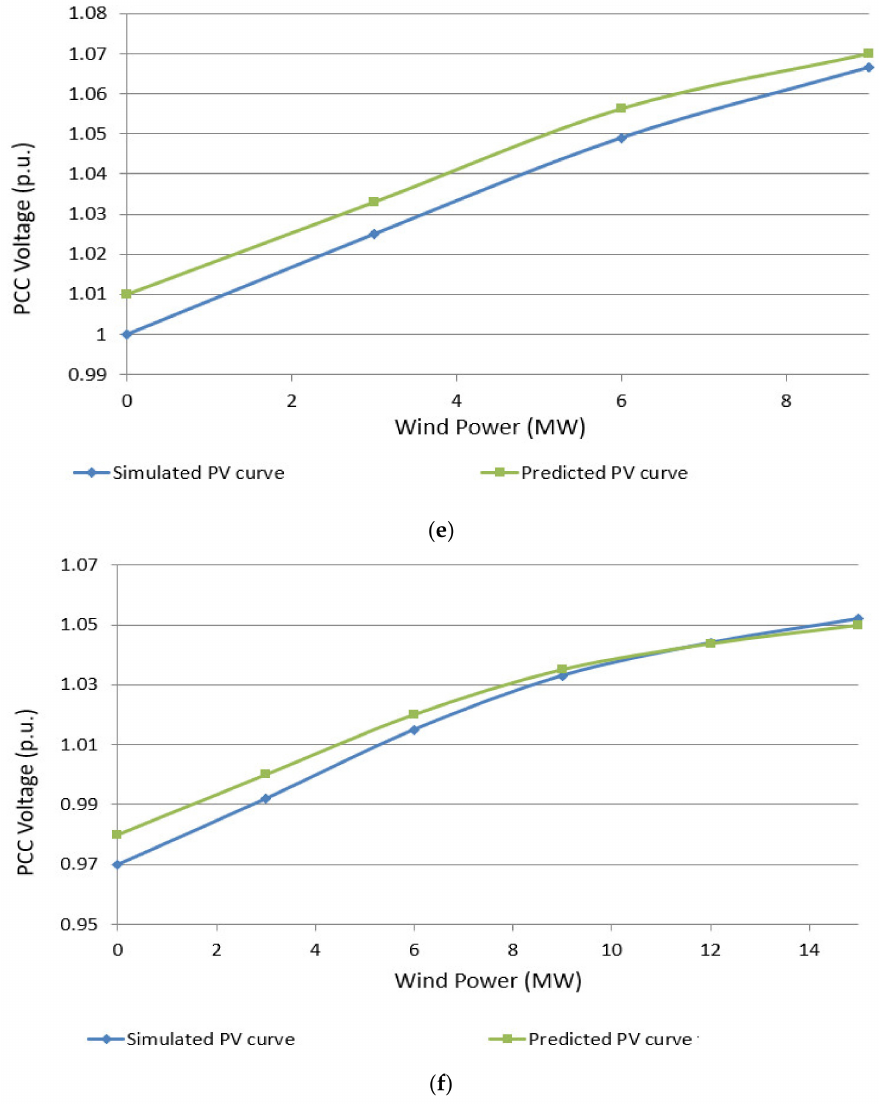
Figure 7. P wind versus V PCC characteristic for validation scenarios considered for the 9-bus and 37-bus test systems. ( a ) Scenario 1; ( b ) Scenario 2; ( c ) Scenario 3; ( d ) Scenario 4; ( e ) Scenario 5; ( f ) Scenario